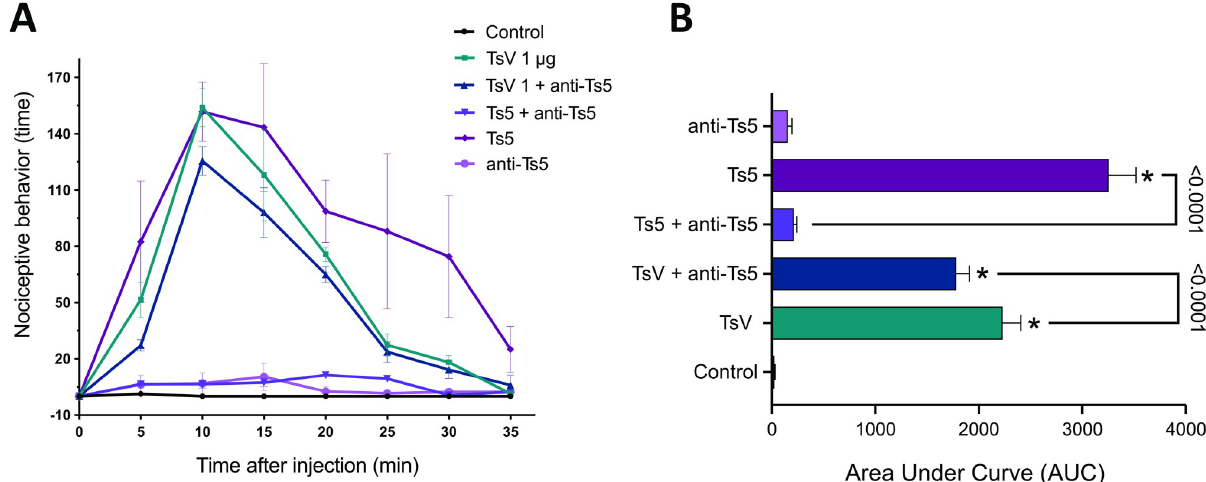
Fig 4. Nociception assays with Ts5 response neutralized. (A) Nociceptive behavior was evaluated in BALB/c male mice (n = 6) using 0.5 μ g/animal paw of TsV as positive control animals. In the tested group of animals, TsV (1 μ g/animal paw) was pre-incubated 1 h at 37˚ C with 2 eqM of purified IgGs anti-Ts5 (considering the % of Ts5 from the whole venom). The same rate was used in the positive control group, using 0.5 μ g of Ts5/animal paw pre-incubated 1 h at 37˚ C with 2 eqM of IgGs anti-Ts5. Animals were observed for 35 min to record the time the animals spent either licking or lifting/ shaking the injected paw. (B) Area under curve (AUC) over any individual parameter in the evaluation of nociceptive response with Ts5 neutralized. Data was analyzed using one-way ANOVA and Tukey’s post hoc test. � p < 0.05, when compared to the control group. Graphs were generated using GraphPad Prism Version